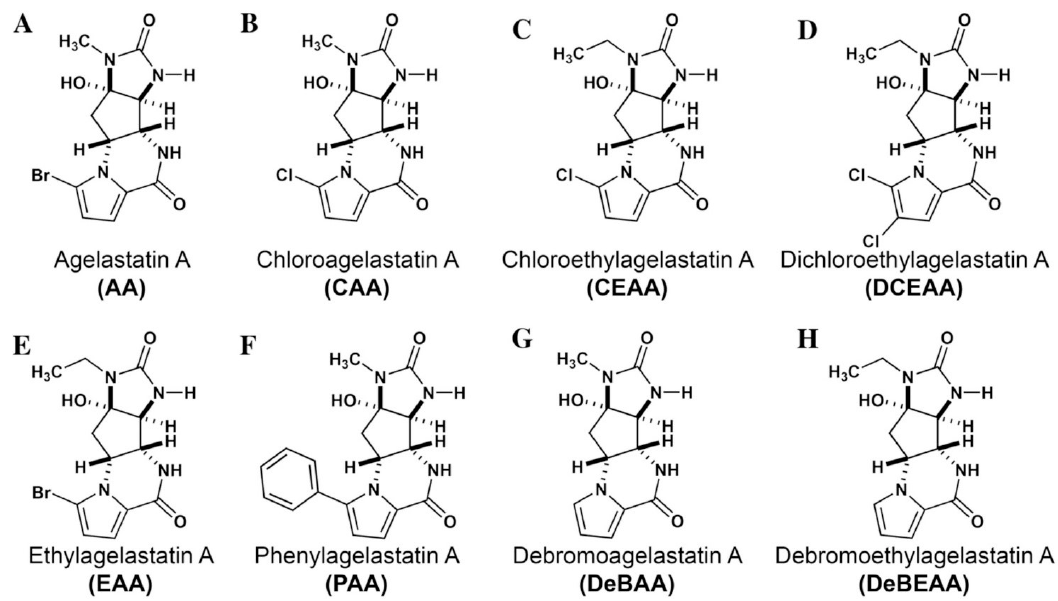
Figure 1. Two-dimensional structures of (-)-Agelastatin A and various analogues analyzed with the docking search algorithm on the ribosome. ( A ) Agelastatin A (AA). ( B ) Chloroagelastatin A (CAA). ( C ) Chloroethylagelastatin A (CEAA). ( D ) Dichloroethylagelastatin A (DCEAA). ( E ) Ethylagelastatin A (EAA). ( F ) Phenylagelastatin A (PAA). ( G ) Debromoagelastatin A (DeBAA). ( H ) Debromoethylagelastatin A